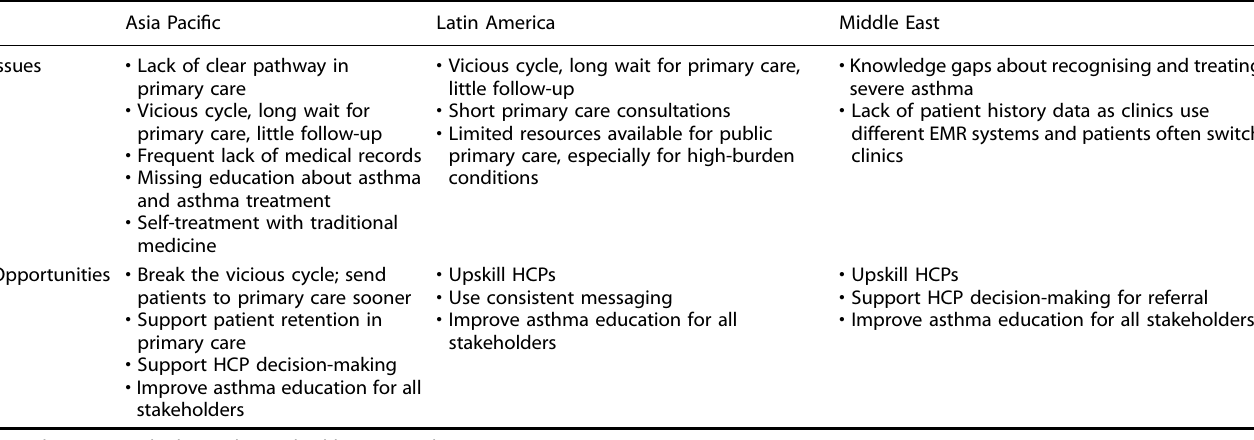
Table 1. Key insights on issues and opportunities in the Asia Paci fi c, Latin America and Middle East